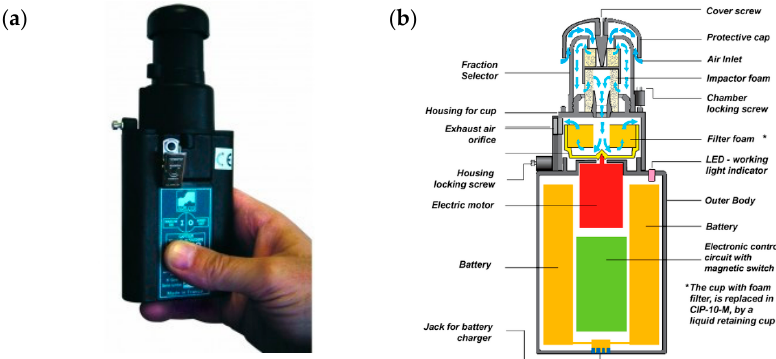
Figure 3. Personal dust sampler ( a ) [36] and schematic of CIP-10 Sampler ( b ) [37].